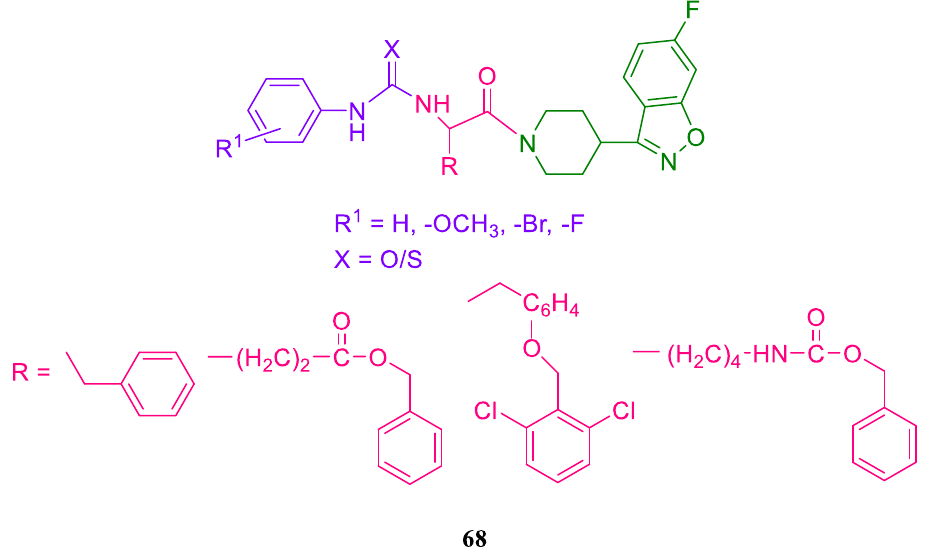
Figure 56. Amino acids-[3-(4-piperidyl)-6-fluoro-1,2-benzisoxazole] conjugates. Sharma A et al. synthesised two series of pentapeptides (GVGVP and GFGVP) con- jugated to 3-(1-piperazinyl)-1,2-benzisothiazole ( 69 ) and evaluated their antiglycation, an- timicrobial, urease and H + /K + -ATPase inhibitory activities (Figure 57). The pentapeptides were synthesised using Boc chemistry in solution-phase and conjugated to the heterocy- cle, followed by converting the N-terminus into ureido and thioureido moieties. The an- timicrobial activity was performed using agar-well diffusion and microdilution methods against various bacterial strains, including both Gram-positive ( C. staphylococcus ), Gram- negative ( K. pneumoniae , E. coli and X. oryzae ) and fungal strains ( F. oxysporum , F. monoli- forme , A. flavus and A. niger ). It was found that GFGVP peptide derivatives exhibited in- creased antimicrobial activity compared to GVGVP counterparts with zone of inhibition values of 33 ± 0.74 mm and 25 ± 0.76 mm, respectively. This could be due to the higher level of hydrophobicity of Phe, thus revealing the importance of hydrophobicity in pre- senting good activity. In urease inhibition and antiglycation studies, the target molecules having para-substituted methoxy group exhibited superior activity with promising IC 50 values of 16 ± 0.26 µM against jack bean urease and bovine serum albumin, whereas in the H + /K + -ATPase inhibition, GVGVP-containing conjugates exhibited an enhanced inhi- bition of 34.0 ± 0.86 µM IC 50 value. A general observation was that the title compounds with thiourea group were more active than their urea counterparts [145]. Figure 57. Pentapeptides conjugated to 3-(1-piperazinyl)-1,2-benzisothiazole. Sidoryk K et al. synthesised a novel series of neocryptolepine analogues ( 70 ) substi- tuted with a dipeptide or an amino acid at C-9 or C-2 position and developed them as highly potent antiproliferative, antimicrobial and antifungal agents (Figure 58). The reaction of N α - tert -butyloxycarbonyl-amino acid with 5,11-dimethyl-5H-indolo [2,3- b ]quinoline-2- ylamine by using a coupling activator, TBTU in the presence of DIEA and HOBt yielded the desired compounds. The peptide derivative of 5,11-dimethyl-5H-indolo [2,3- b ]quinoline-2- ylamine was also synthesised by the coupling of 5,11-dimethyl-5H-indolo [2,3- b ]quinoline- 2-yl-glycylamide dichloride with Boc-N α -Gly using TBTU method in DMF. The in vitro antiproliferative activity was performed against KB cells (cervix carcinoma), which revealed that all the analogues exhibited a higher enhanced activity than the reference standards with promising IC 50 values ranging between 0.42 and 0.47 µ M. However, glycylglycine- and L-His-substituted conjugates showed lesser activity with 1.54 µ M and 3.88 µ M as IC 50 values, whereas (DOX) doxorubicin hydrochloride and DiMIQ exhibited 0.84 µ M and 1.14 µ M as their IC 50 values. Furthermore, the activity of the Gly conjugate substi- tuted at C-2 position showed enhanced activity than C-9-substituted counterparts. The selected analogues were also examined for the antiproliferative activity against colon cancer LoVo, breast cancer MCF-7, non-small cell lung cancer A549 and normal mice fibroblast BALB/3T3, which revealed that majority of the synthesised conjugates showed enhanced activity, especially the Gly analogue of DiMIQ, which exhibited the highest activity